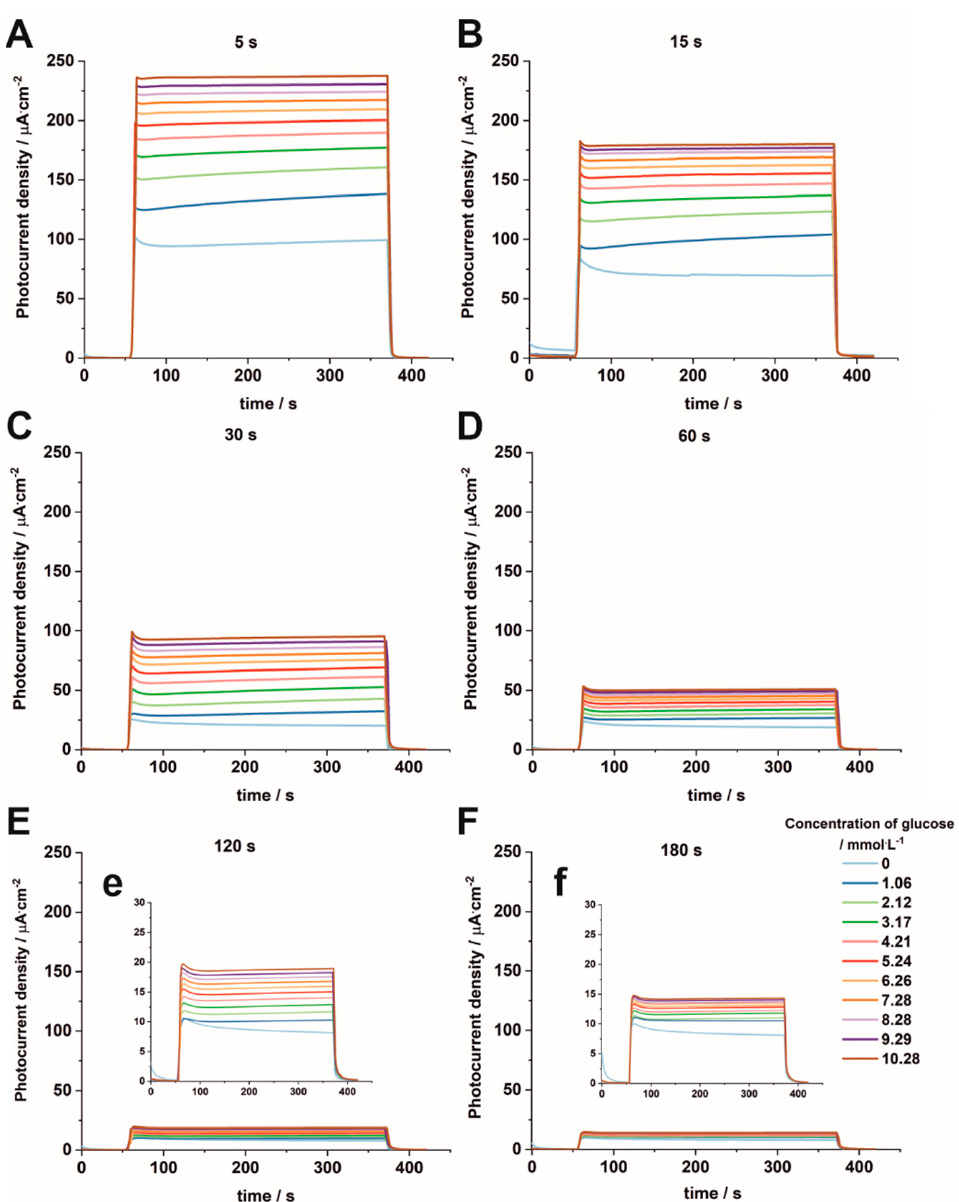
Figure 10. Photocurrent density vs. time curves measured at 1 V vs. SCE in 0.1 M KNO 3 containing 1.06–10.28 mM of glucose under solar irradiation for samples deposited after 5 s ( A ), 15 s ( B ), 30 s ( C ), 60 s ( D ), 120 s ( E ), and 180 s ( F ), with insets ( e ) and ( f ).